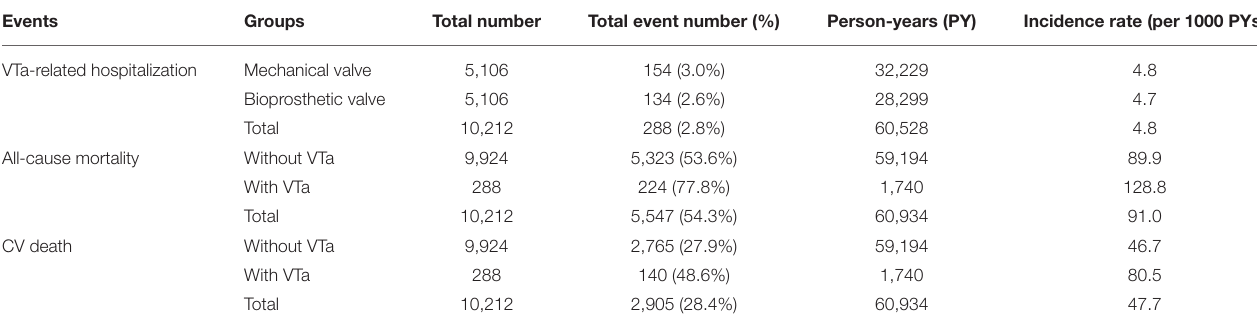
TABLE 2 | Incidence rates of subsequent events in various groups.